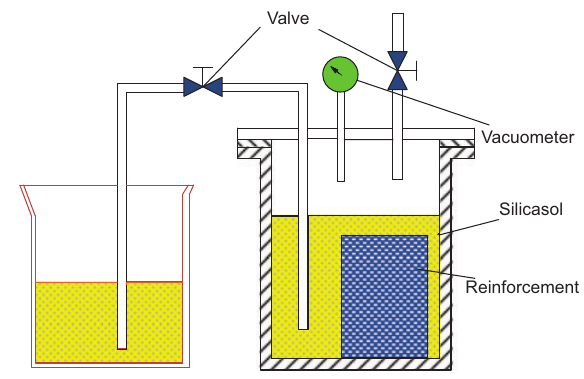
Figure 1 Schematic diagram of the SIS